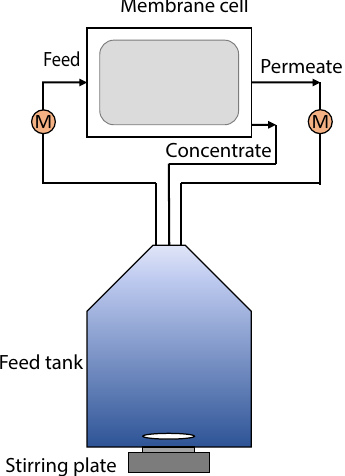
Figure 2. Schematic representation of the membrane filtration setup. The feed, concentrate and permeate flows are all regulated by the Con-Vergence OSMO setup, the feed and permeate mass flow are measured by mass flow meters